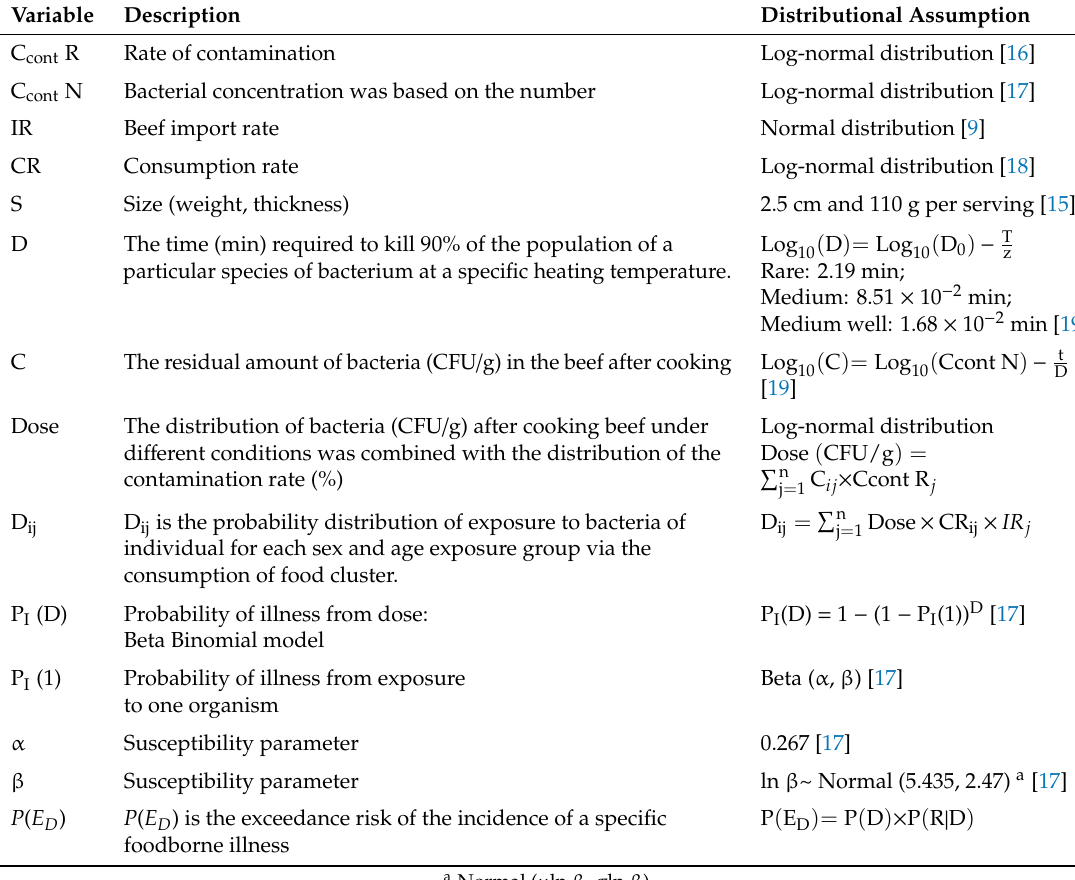
Table A1. Summary of the